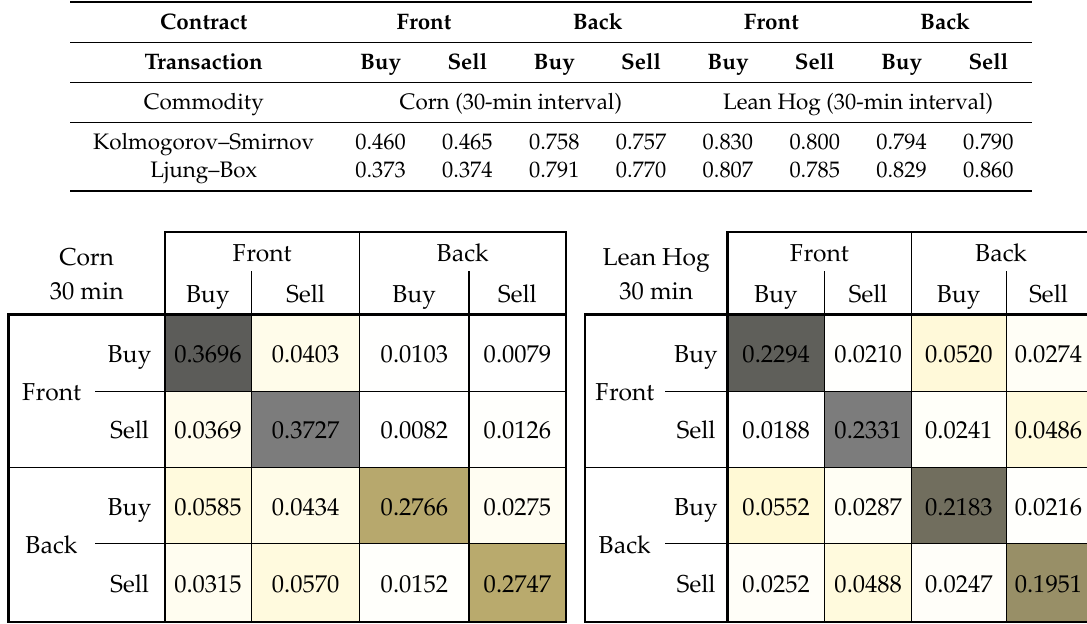
Figure A1. Estimated matrices of kernel norms (corn, lean hogs) for a 30-min interval.